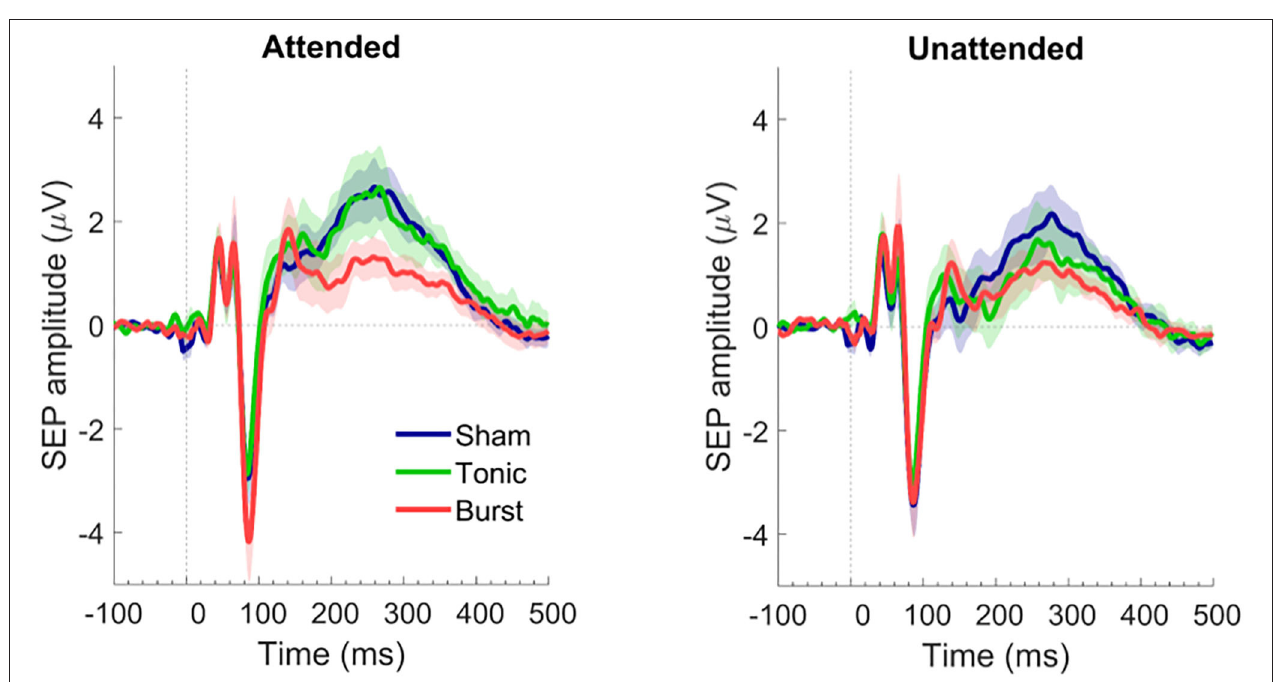
FIGURE 3 | Somatosensory evoked potential in attended (left) and unattended (right) conditions on the vertex for each type of spinal cord stimulation: sham SCS (blue), tonic SCS (green), and burst SCS (red). Shadows indicate standard error of the mean (200 epochs per condition, n = 12 subjects).